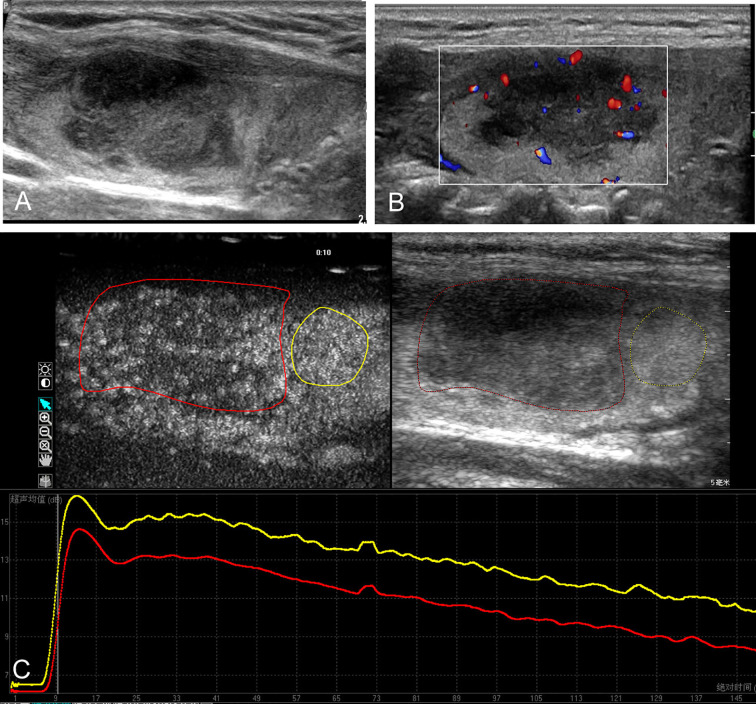
Conventional ultrasound and contrast-enhanced ultrasound images of the primary thyroid lymphoma in the right thyroid lobe of a 67-year-old female with Hashimoto’s thyroiditis background. (A) B-mode ultrasound image of a maximum diameter of 28 mm nodule displayed hypoechogenicity with ill-defined margin. (B) Color Doppler image revealing the internal and peripheral mixed distributed vascularity of the nodule. (C) Contrast-enhanced ultrasound image revealing the heterogeneous hypo-enhancement of the lesion (red circle), with respect to the surrounding parenchyma (yellow circle); time–intensity curves of the lesion (red line) and parenchyma (yellow line) were generated to calculate the corresponding quantitative parameters.